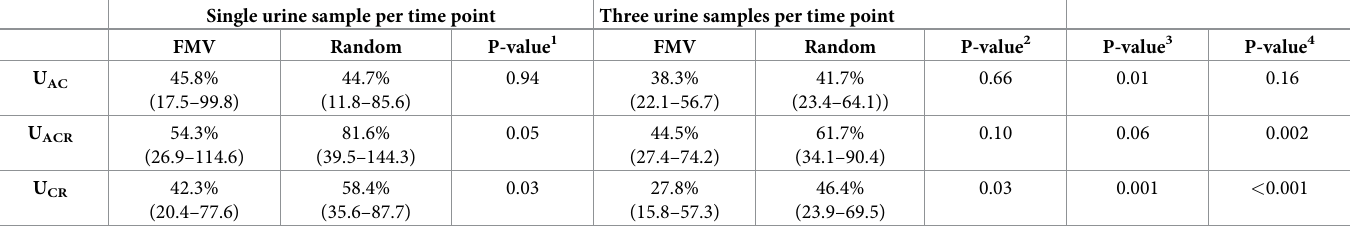
Table 2. Intra-individual coefficients of variation by number of samples and by collection time (median (25 th – 75 th percentile). Single urine sample per time point Three urine samples per time